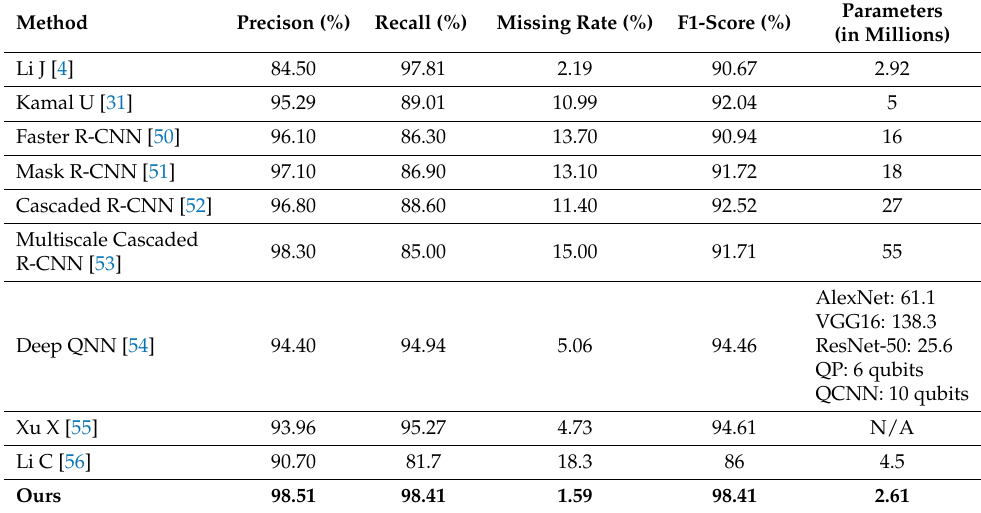
Table 4. A performance comparison of traffic sign detection methods on